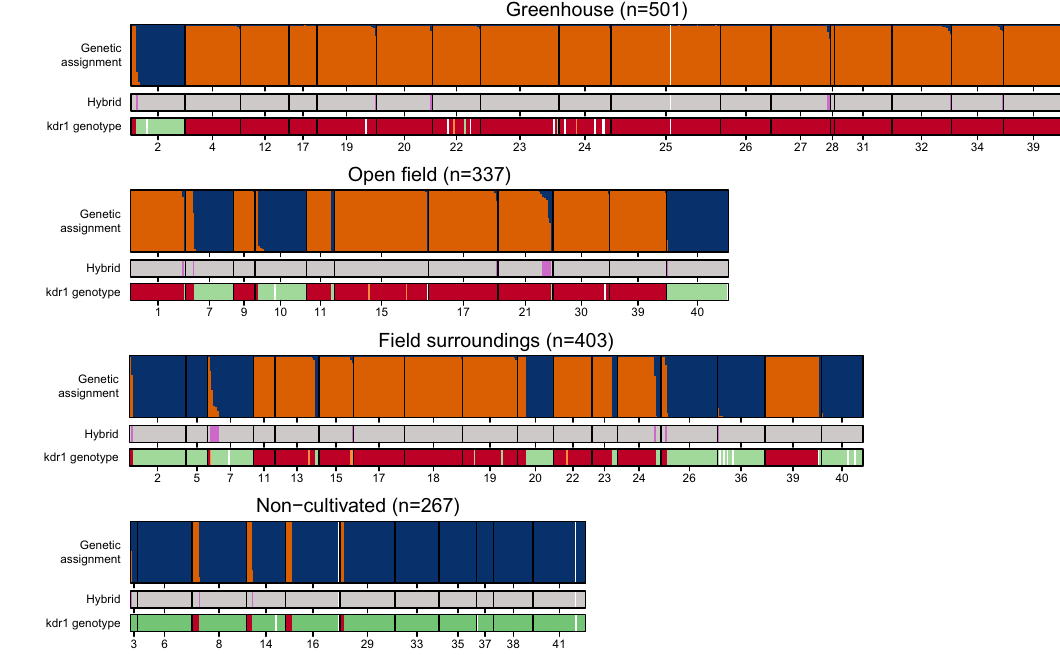
Figure 4. Genetic assignment to the MEAM1 (orange) and the IO (blue) genetic clusters, identification of hybrids (pink bars) and kdr genotype at the L1 locus (green for SS, orange for RS and red for RR) of individuals sampled in greenhouse, open field and field surroundings. Missing data are indicated by white bars. Individuals are ordered by their probability of assignment to the clusters. Numbers on the X-axis correspond to sampling sites as referred to in Table